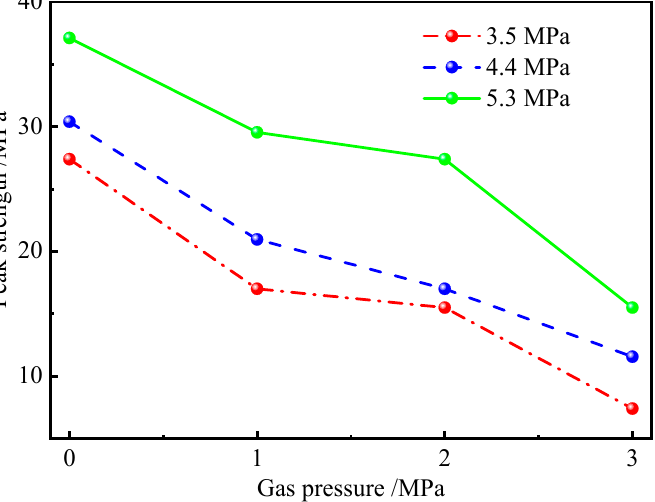
Figure 4. Evolution of peak strength with gas pressure under different confining pressure condi- tions.